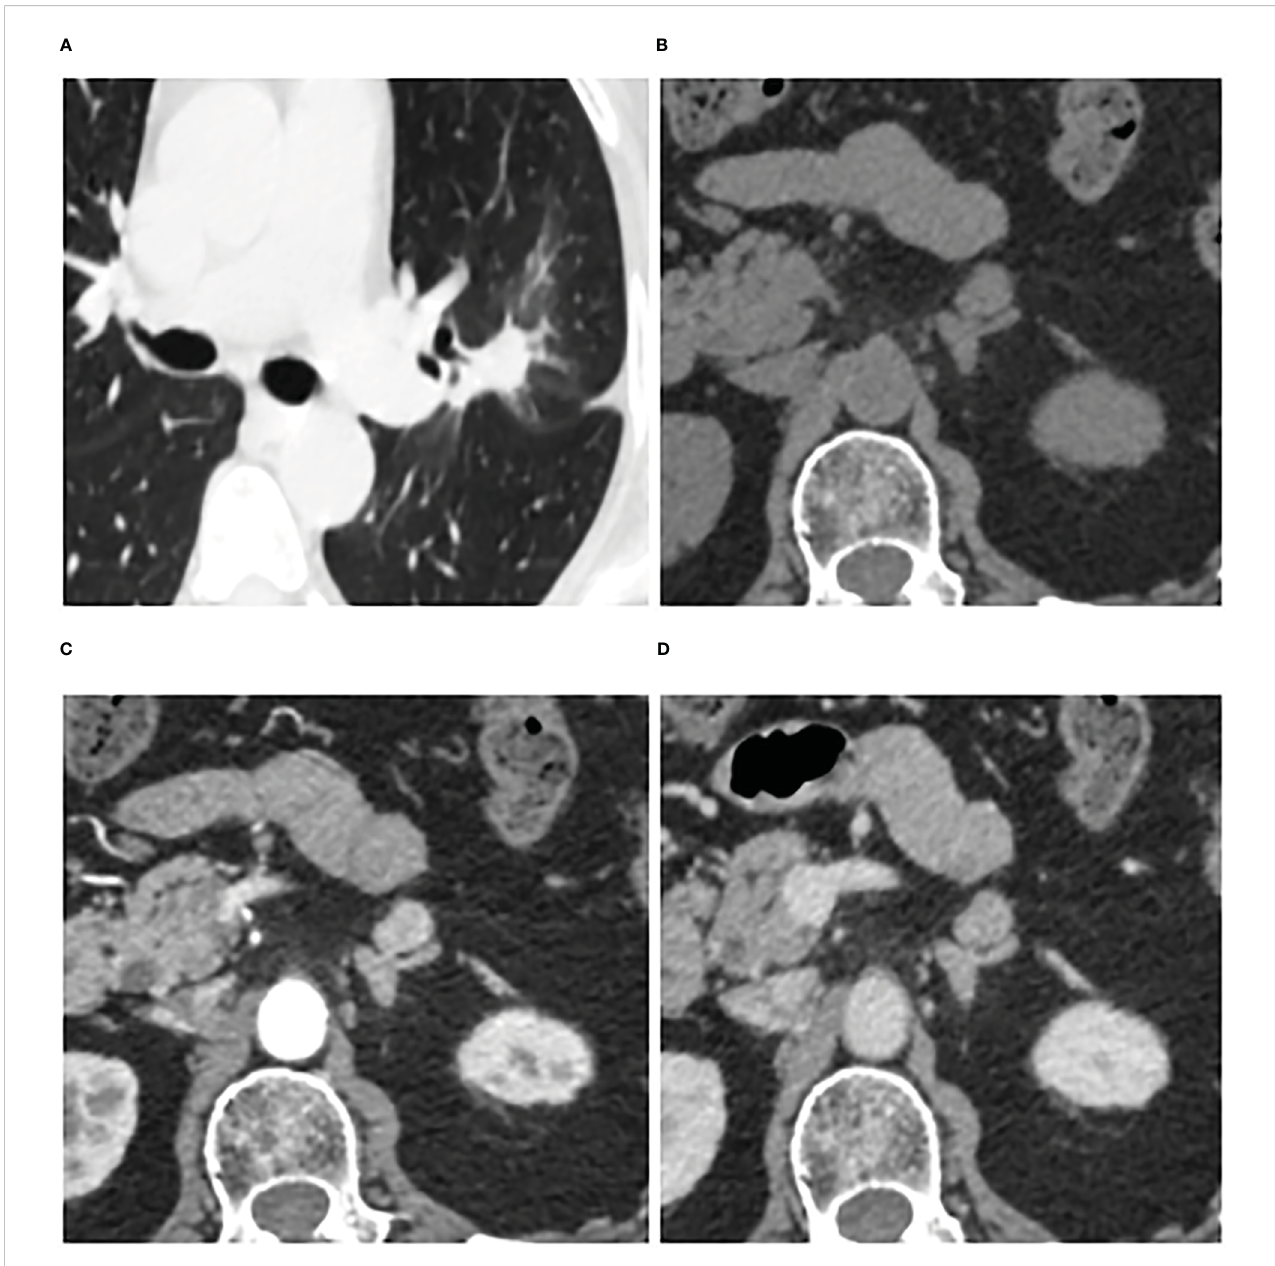
FIGURE 5 Adrenal adenoma in a 72-year-old woman. Pulmonary window of primary nonsmall-cell lung cancer (stage IV) (A) and unenhanced phase (B) , arterial phase (C) , and venous phase (D) of adrenal nodular showed a 13 mm × 11 mm tumor in left adrenal. Attenuation values on unenhanced, arterial, and venous phase were 39, 127, and 101 HU, respectively. The enhancement ratio on venous phase was 1.59. No cystic degeneration was seen within the nodular. Peak enhancement phase was arterial phase. The nodular got a score of 6 points, indicating diagnosis of